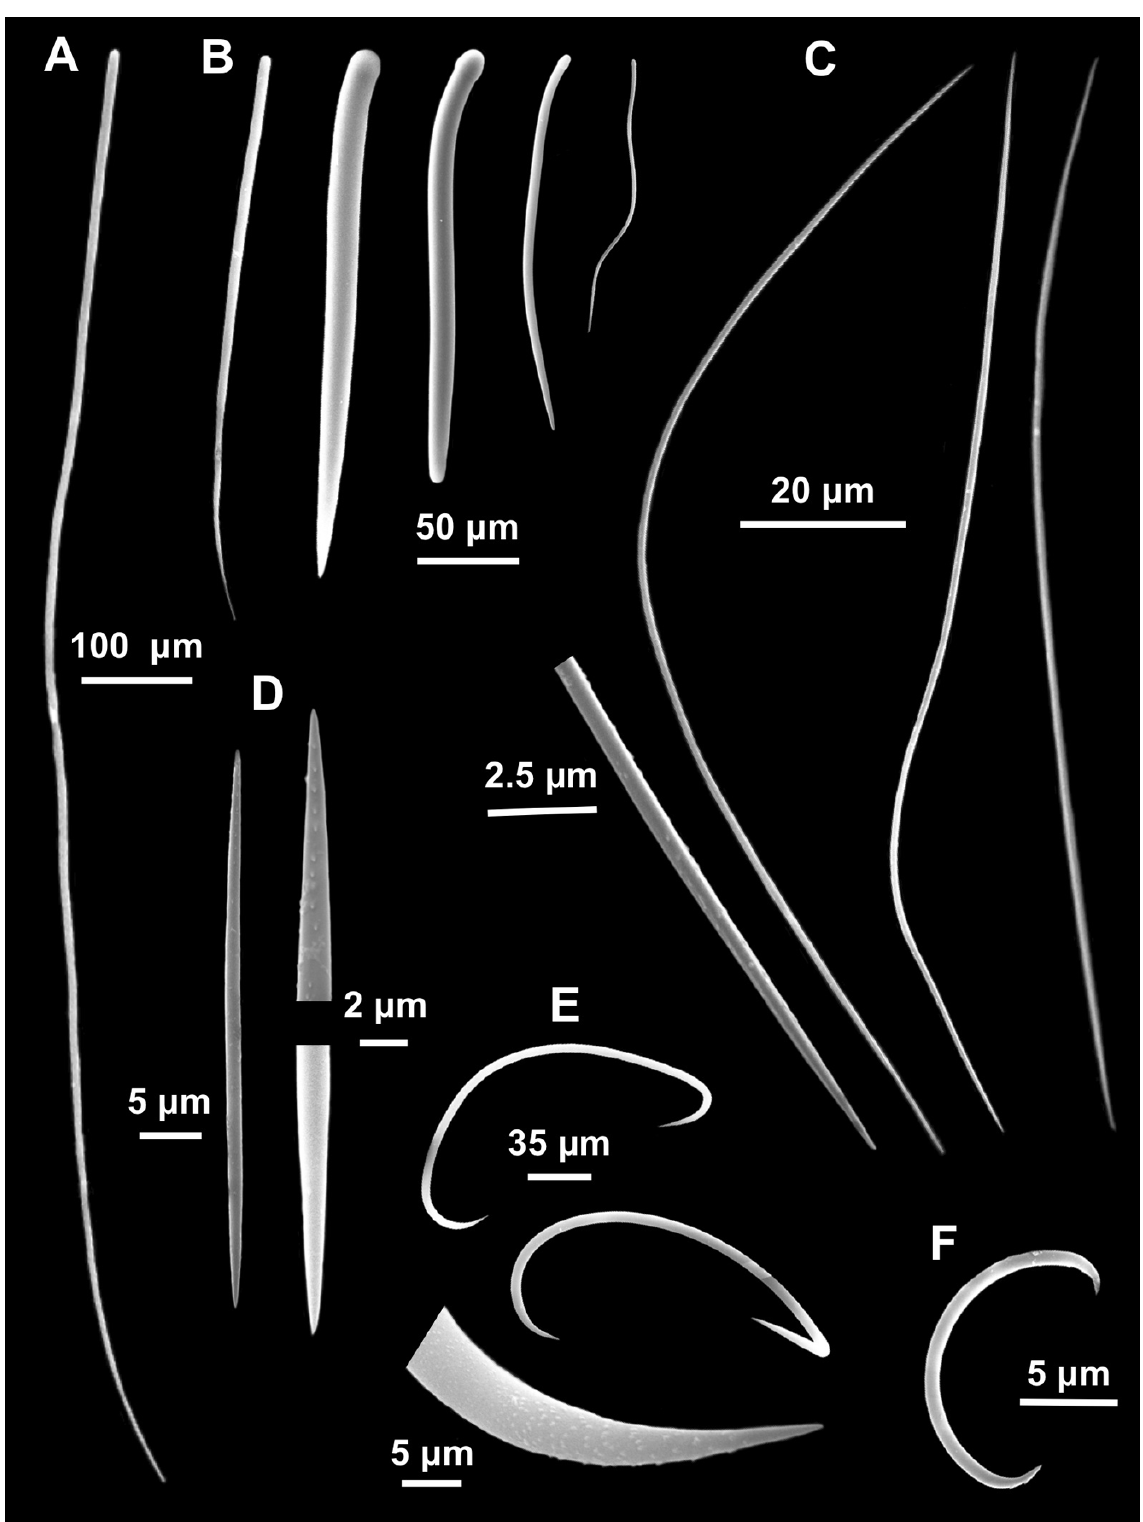
Fig. 8. Spicules of Biemna aurantiaca Bertolino, Costa & Pansini sp. nov., holotype (CILE 20; MSGN 61497). A . Sinuous styles. B . Tylostyles. C . Raphids I. D . Raphids II. E . Sigma I. F . Sigma